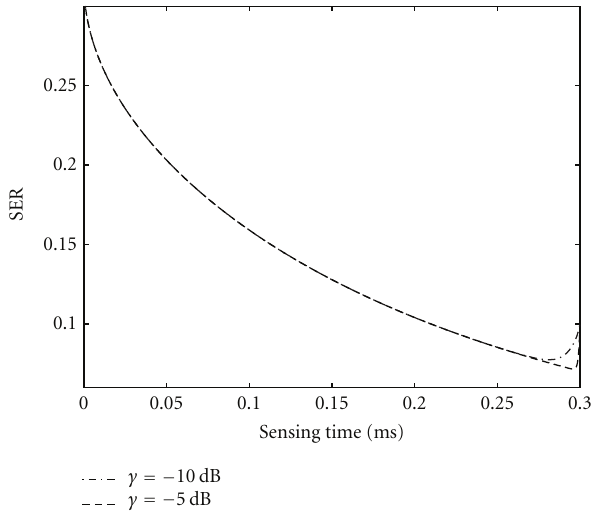
Figure 3: SER as a function of the symbol time ( T s